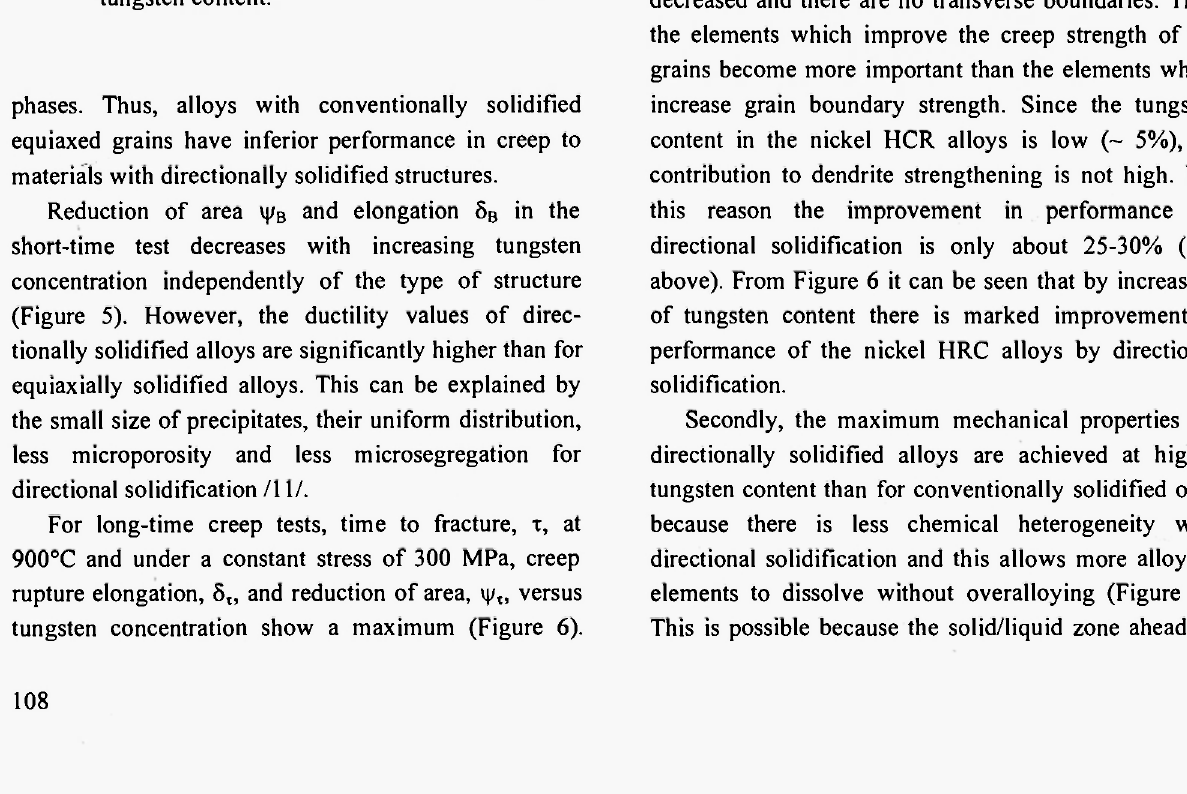
Fig. 6: Creep rupture properties [time to fracture (τ), reduction of area (ψ,), elongation (δ Τ )] of the equiaxially (x) and directionally (o) solidified alloys at 900°C and load 300 MPa versus tungsten